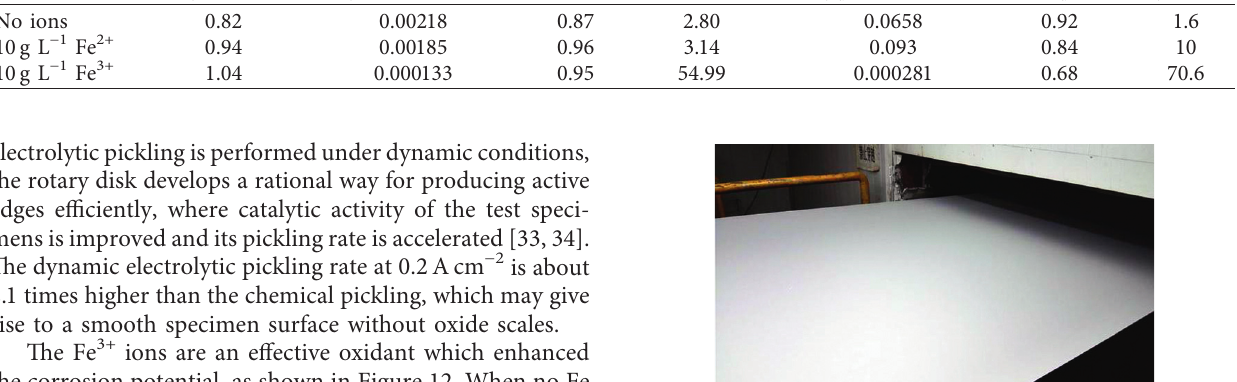
Table 3: Fitted results for EIS spectra in 300g L − 1 H Ions